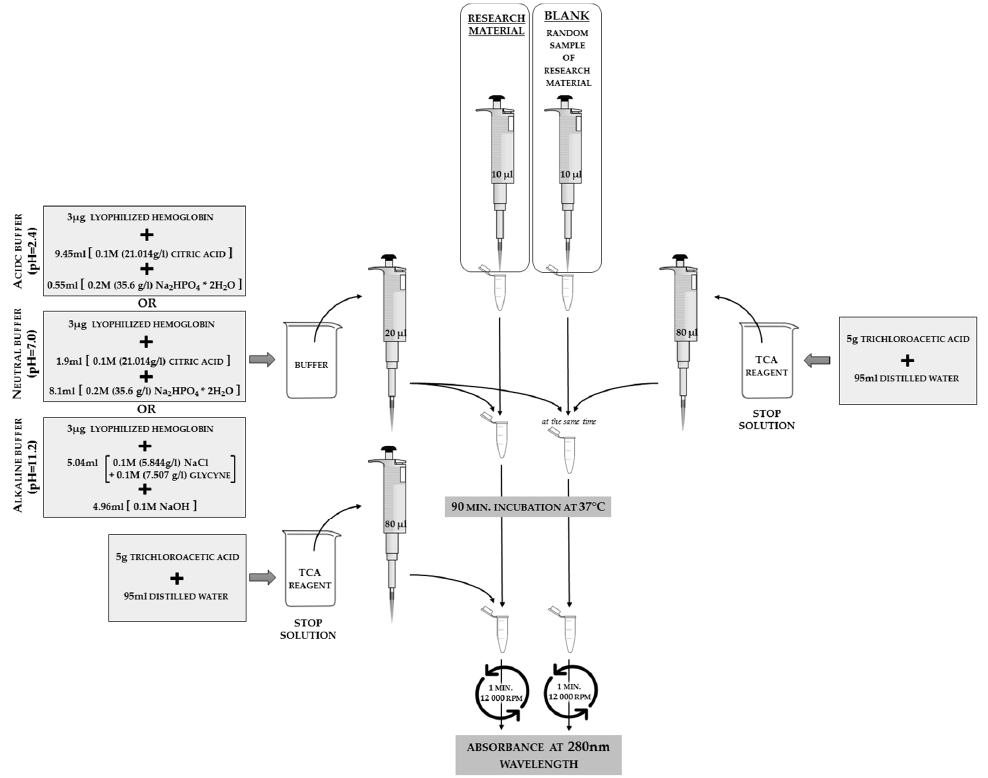
Figure 7. The schemes for acidic (2.4 pH), neutral (7.0 pH), and alkaline (11.2 pH) protease activity